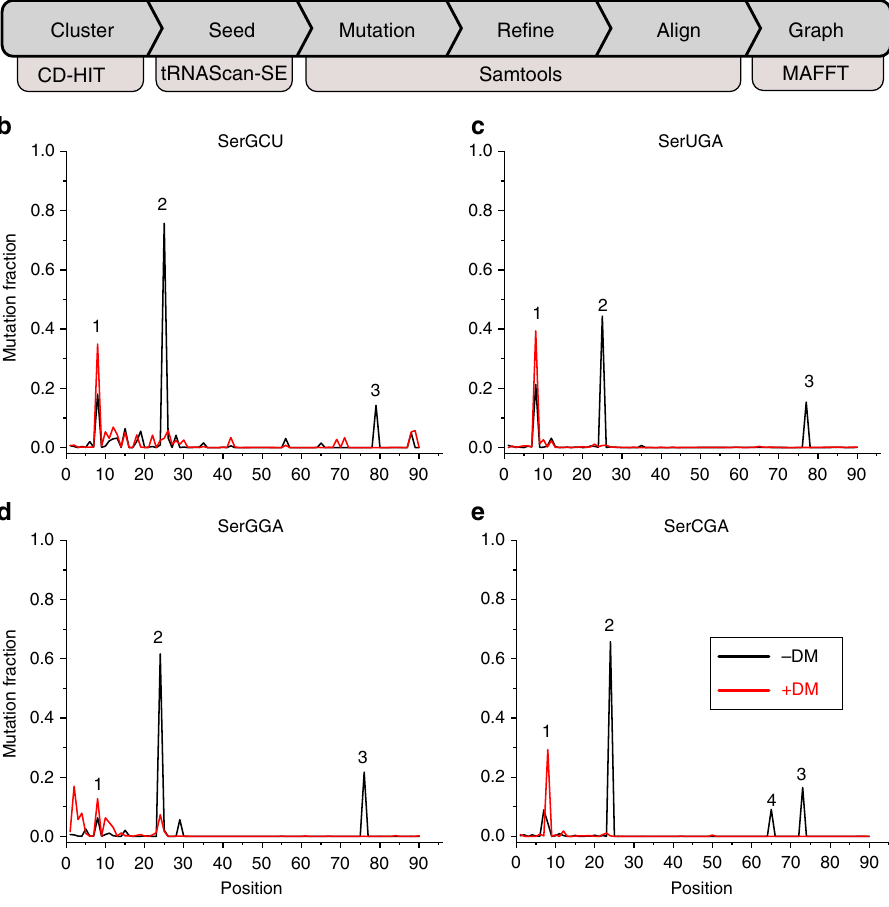
Fig. 4 Microbiome tRNA modi fi cation analysis. a Work fl ow for modi fi cation assignment using mutation signatures. b – e Representative positional plots showing m 1 A and s 4 U modi fi cations for transcripts of tRNA Ser (GCU) ( b ), tRNA Ser (UGA) ( c ), tRNA Ser (GGA) ( d ), and tRNA Ser (CGA) ( e ), HF-fed mouse sample. The peak numbers correspond to those described in the text with peak 1 called for s 4 U8 and peak 2 for m 1 A22. Peak 3 is located around nucleotide 73 – 79 in the type II tRNA Ser s, but is m 1 A59 in the standard tRNA nomenclature. Red and black lines show mutation fractions in tRNA Ser sequences with ( + DM) and without ( − DM) demethylase treatment,